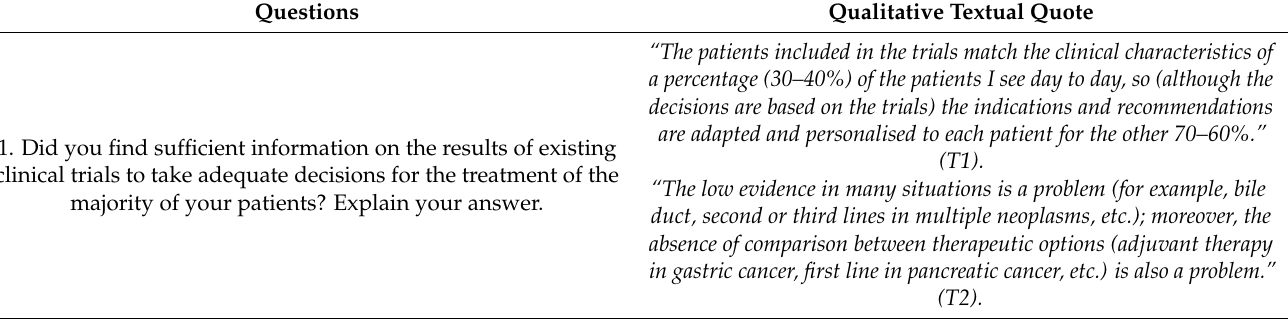
Table 2. Qualitative analysis of the assessment of usual practice in the case of there being no clinical trials in progress in your hospital. Galicia, 2020.